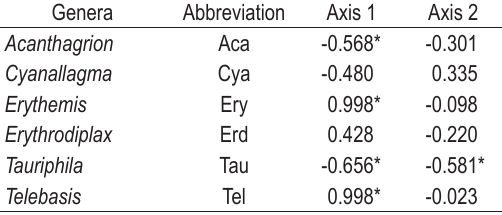
and the first two CCA axes.